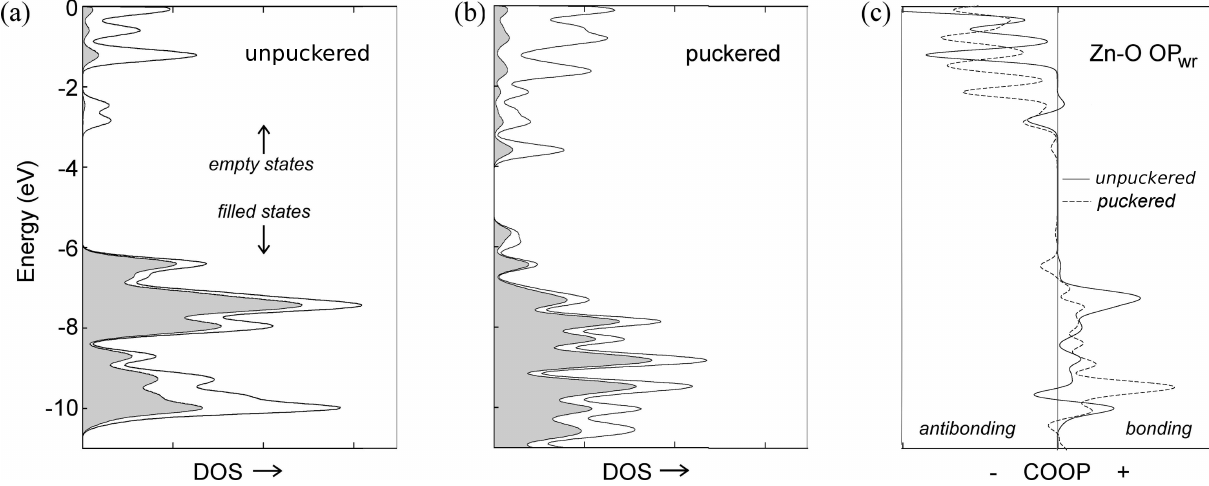
Figure 5. Density-of-states (DOS) curves for finite unpuckered ( a ) and puckered ( b ) Zn needles. The shaded regions indicate O-based states. ( c ) COOP curves showing intra-ring Zn-O overlap population in the unpuckered (solid line) and puckered (dashed line) needles.